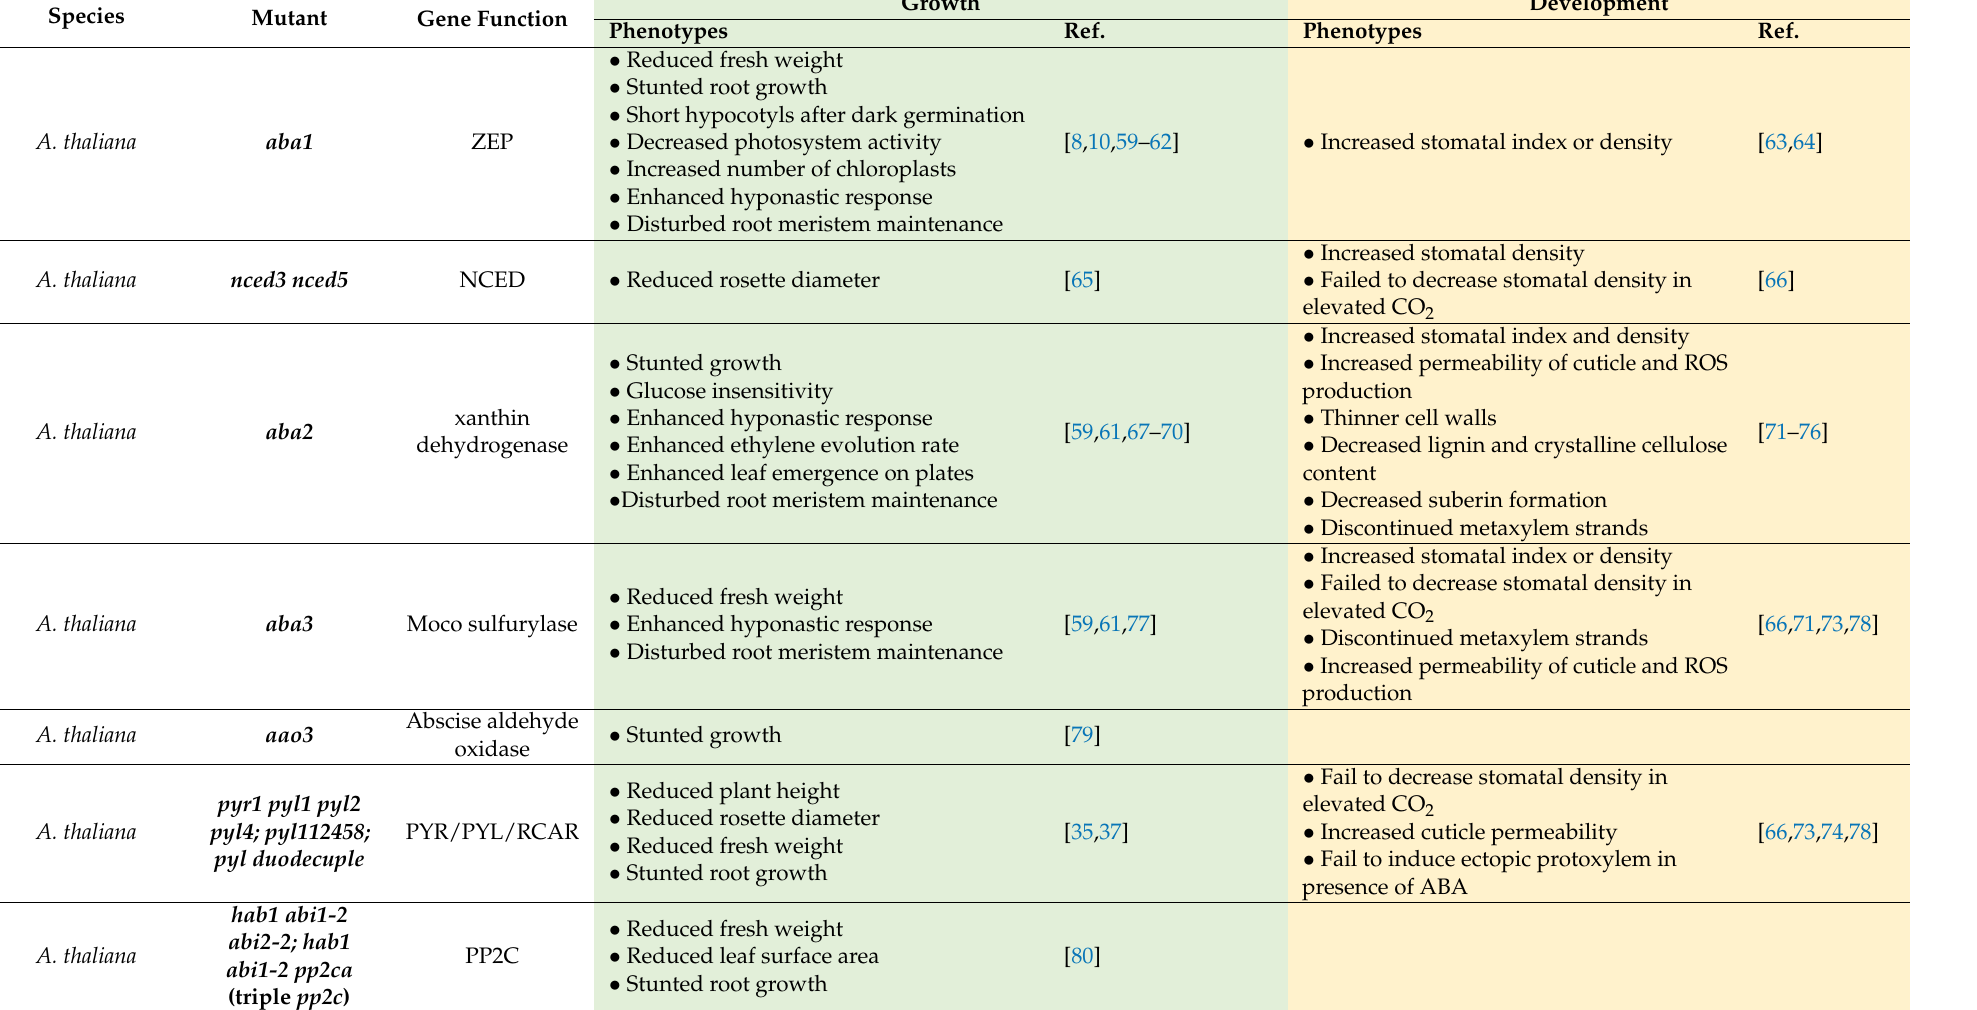
Table 1. Growth and developmental phenotypes of ABA metabolism and signaling mutants described in this article. Growth-related and development-related phenotypes of mutants are highlighted in green and yellow,